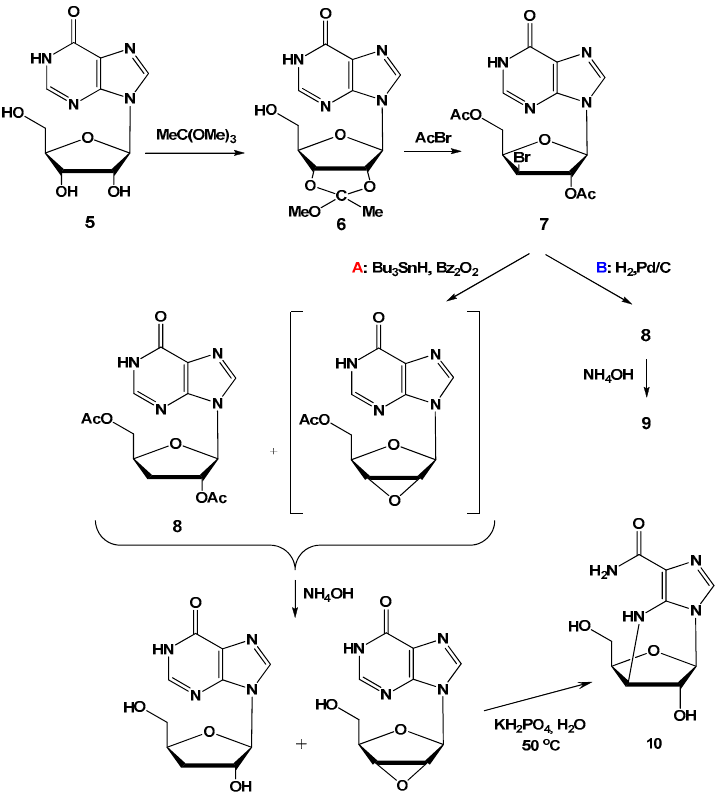
Scheme 1. The synthesis of 3 ′ -deoxyinosine ( 9 ). The first trial syntheses of 2-fluorocordycepin using purine nucleoside phos- phorylase (PNP) (Scheme 2) yielded encouraging results: the conversion of 2-